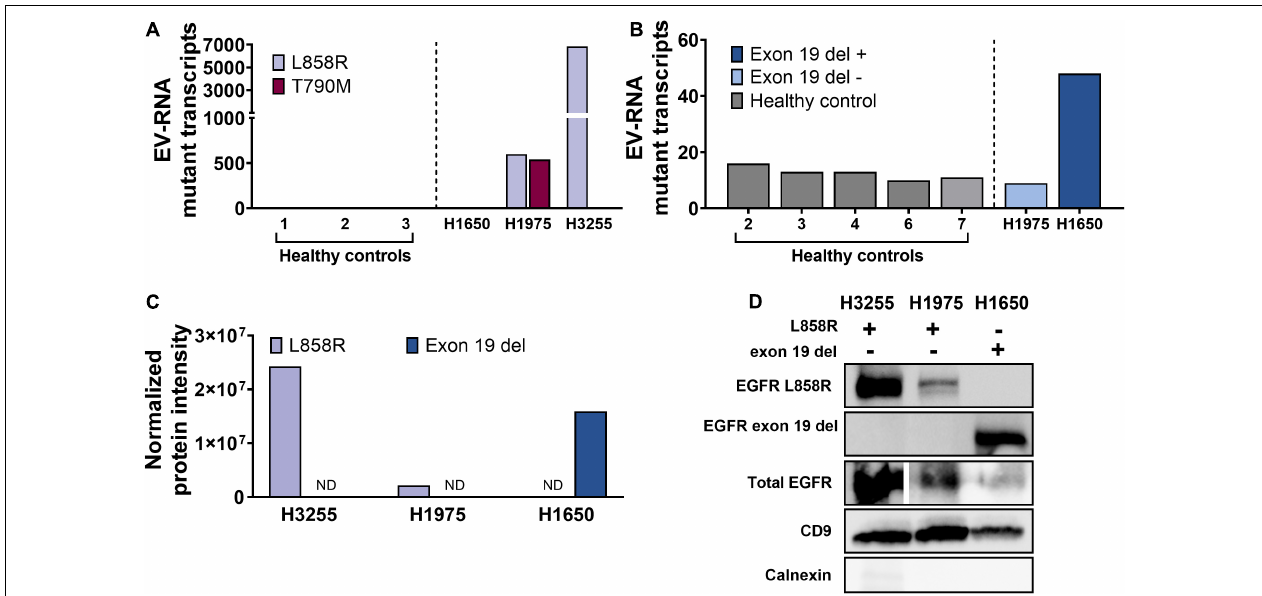
FIGURE 1 | EGFR mutations carried in RNA and protein from cell line derived EVs H1975 (L858R/T790M), H3255 (L858R), H1650 (exon 19 del). (A,B) EV-RNA ddPCR droplet counts of lung cancer cell line-derived and healthy plasma for (A) L858R and T790M point mutations and (B) exon 19 del. (C) Normalized protein intensity for L858R and exon 19 del EGFR mutations from cell line derived extracellular vesicles using western blots. Normalized protein intensity was calculated using Bio-Rad’s Stain Free Blot technology to compare specific bands to the total protein of each lane. (D) Western blot of cell line derived EVs tested for L858R, exon 19 del, total EGFR, CD9, and calnexin. ND, not detected.